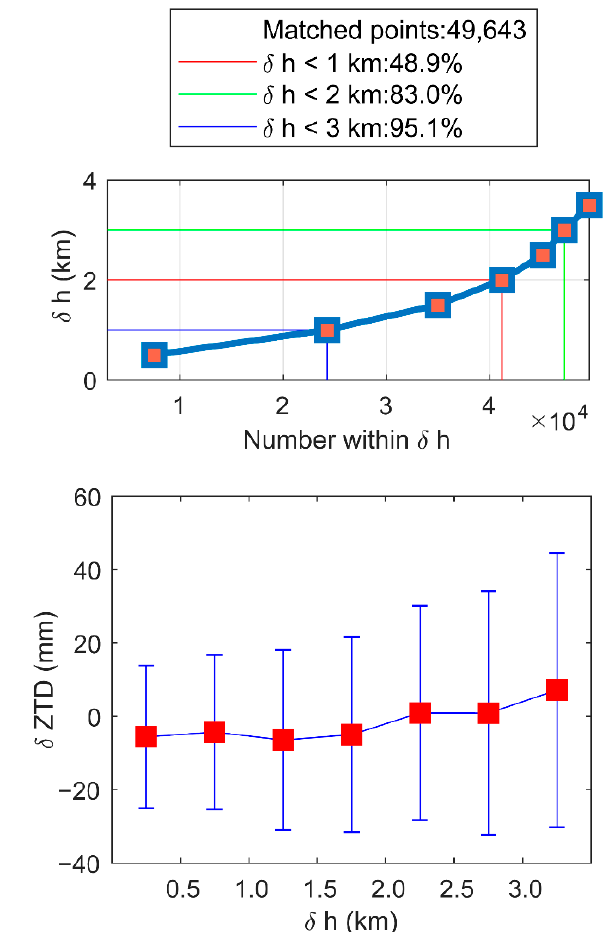
We used δZTD 3 obtained by a filter with a vertical distance of 3 km to analyze the